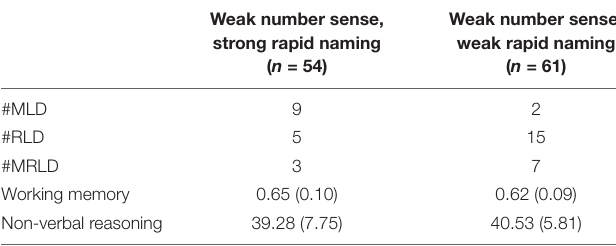
TABLE 8 | Background characteristics for the follow-up